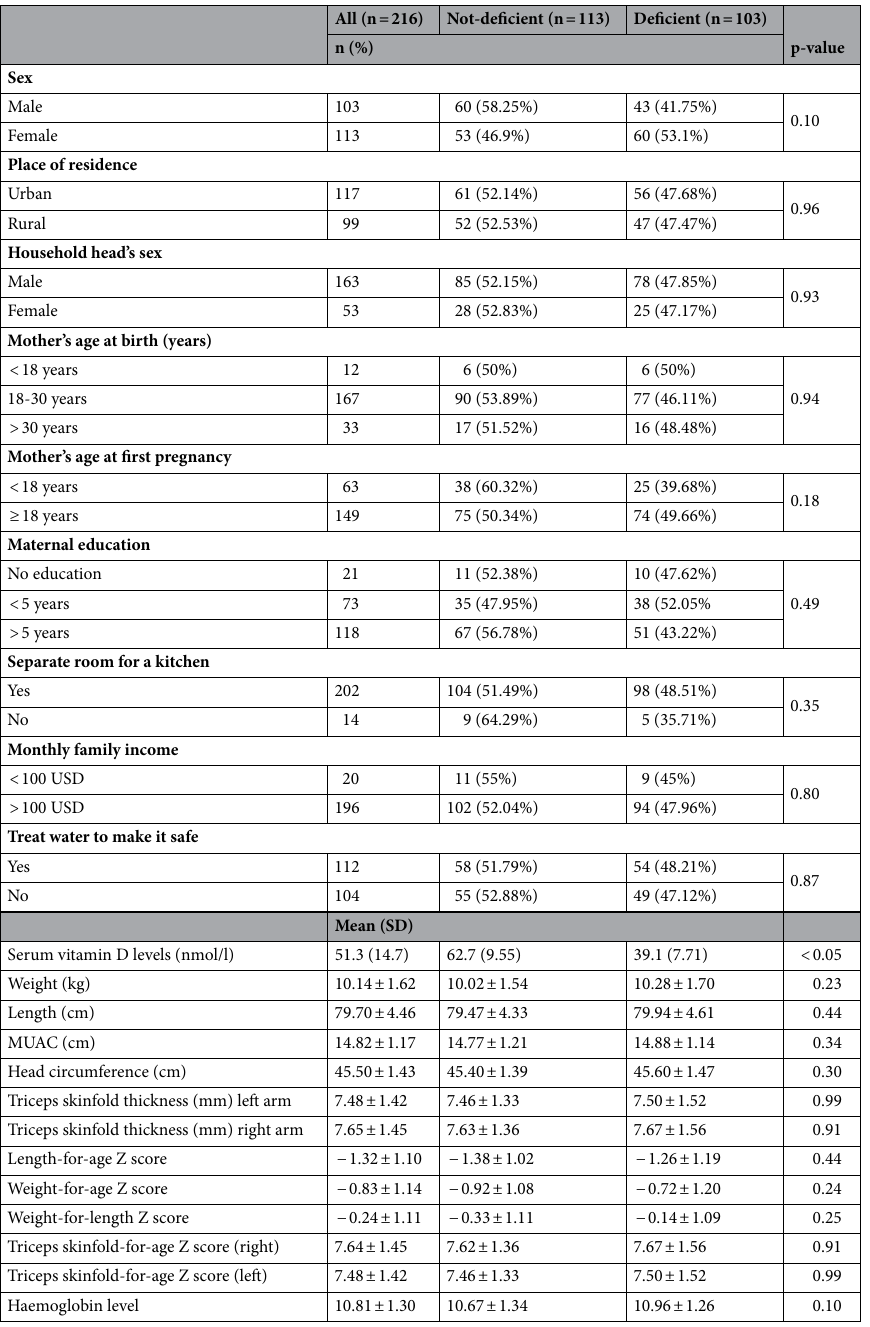
Table 1. Baseline socio-economic and anthropometric characteristics of the